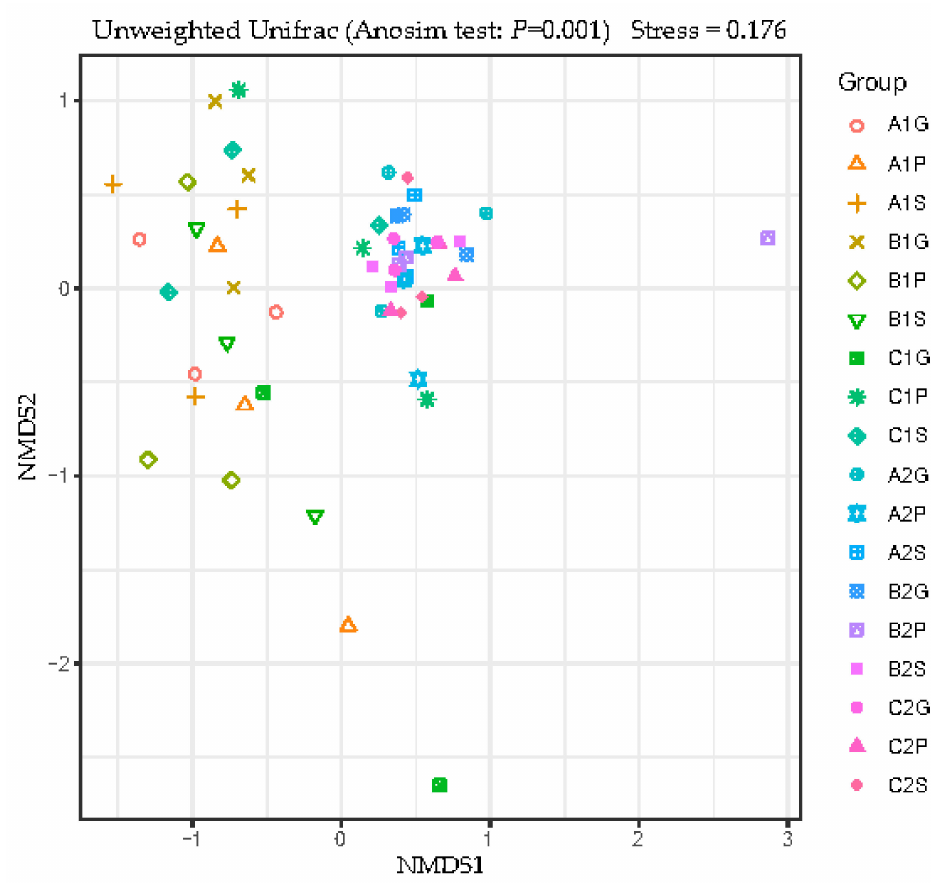
Figure 6. The nonmetric multidimensional scaling (NMDS) analysis. Notes: A1S, B1S, and C1S represent the stomach samples in the low-, medium-, and high-density groups at the beginning of the study, while A1P, B1P, and C1P represent the pyloric caecum samples in the low-, medium-, and high-density groups at the beginning of the study, and A1G, B1G, and C1G represent the gut samples in the low-, medium-, and high-density groups at the beginning of the study, respectively. Likewise, A2S, B2S, C2S, A2P, B2P, C2P, A2G, B2G, and C2G represent the stomach, pyloric caecum, and